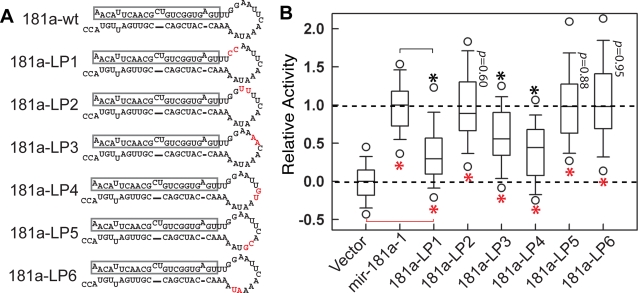
The activity of mir-181a-1 is sensitive to nucleotide changes in its pre-miRNA loop.(A) Schematics of the pre-miR-181a-1 loop mutants. (B) The effects of pre-miR-181a-1 loop mutants on DP cell development. Normalized data from six independent T cell assays (each with 12 independent replicates for a total of 72 replicates) is shown. Mann-Whitney Rank Sum Tests were performed (
Table S3
 for statistics) to determine whether the activities of the loop mutants were statistically different from those of the negative control vector (red *, p<0.0001) and/or the mir-181a-1 positive control vector (black *, p<0.0001). A representative OP9-DL1 stromal co-culture assay (12 independent replicates) without normalization is also shown (
Fig. S7
).